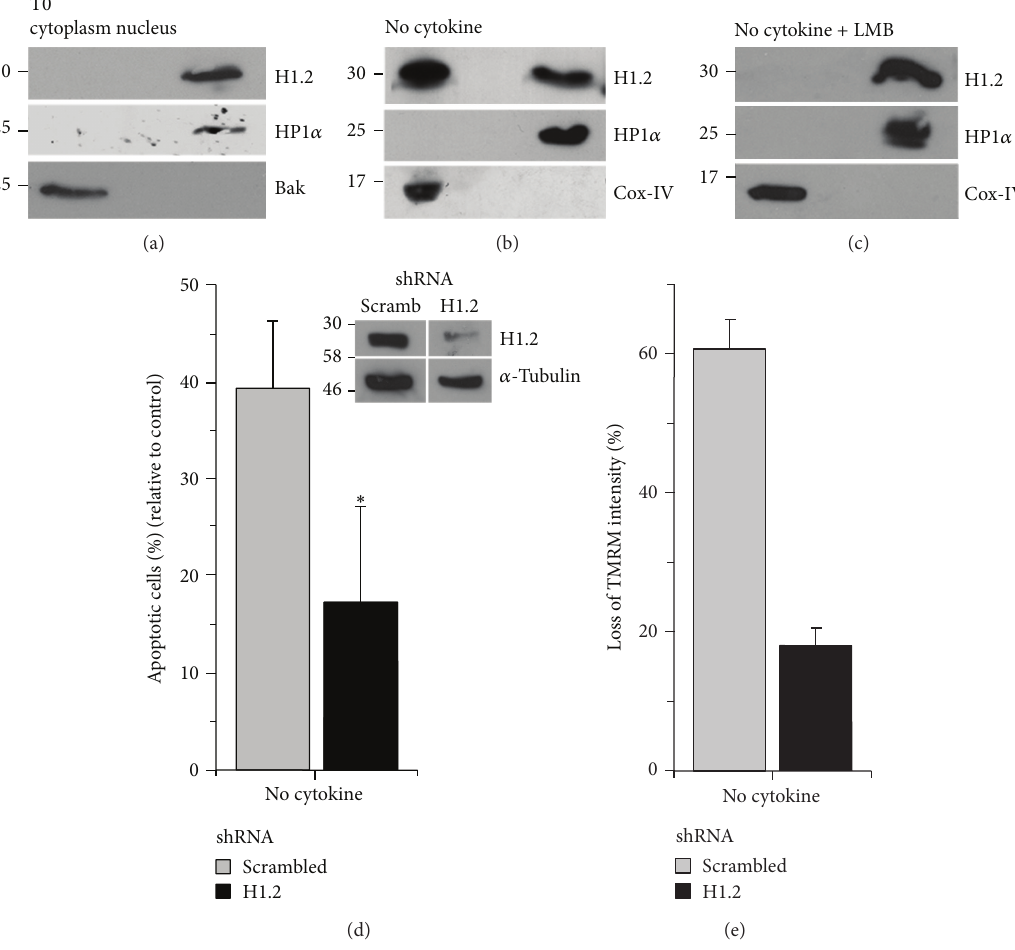
Figure 2: H1.2 is an intermediate in the apoptotic cascade triggered by cytokine deprivation. (a)–(c) 10×10 6 T-effectors were cultured in the indicated conditions (T0: freshly activated) and 6 hours later subject to subcellular fractionation. Immunoblots of nuclear and cytoplasmic fractions were probed for H1.2, HP1 𝛼 , Bak, or Cox-IV. Data are representative of three independent trials. (d)-(e) T-effectors transduced using retrovirus expressing scrambled control or histone H1.2 shRNA, as described in Materials and Methods, were cultured with or without cytokine for 10 hours. Cells were scored for apoptotic nuclear damage using Hoechst-33342 (d) or mitochondrial transmembrane potential using TMRM (e) as described in Materials and Methods. Graphs show mean ± SD from 5 experiments in (d) and 2 experiments in (e), normalized to cultures with cytokine. Inset: Immunoblot for H1.2 protein and tubulin (parity in loading) in shRNA expressing T-effectors. ∗ 𝑃 < 0.01